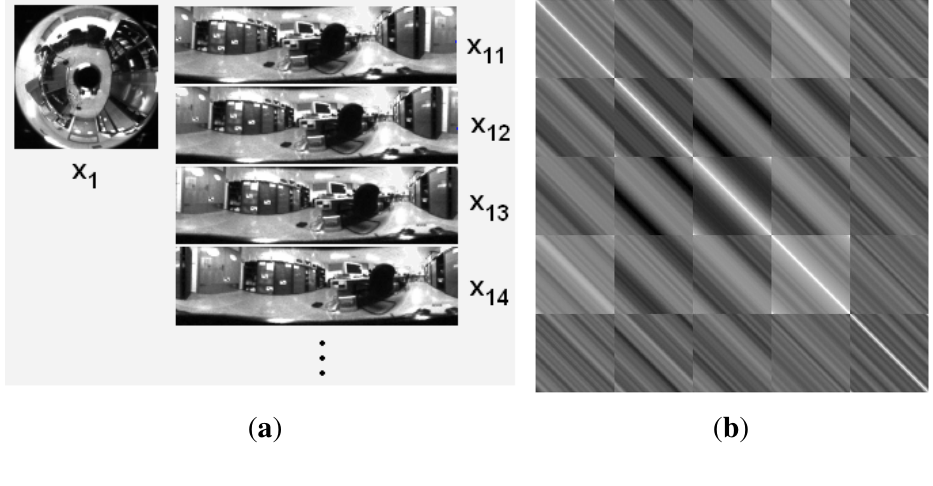
Figure 1. ( a ) Omnidirectional image ( x samples of artificially rotated versions ( x images ( b ) Inner product matrix Q corresponding to a set of images from P = 5 locations and N = 128 rotations per